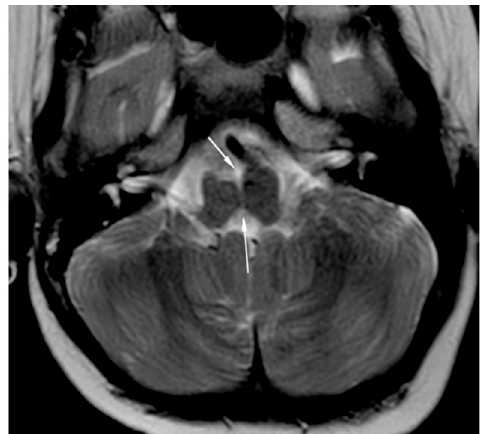
Figure 4. MRI brain axial T2-weighted image showing split pons sign.